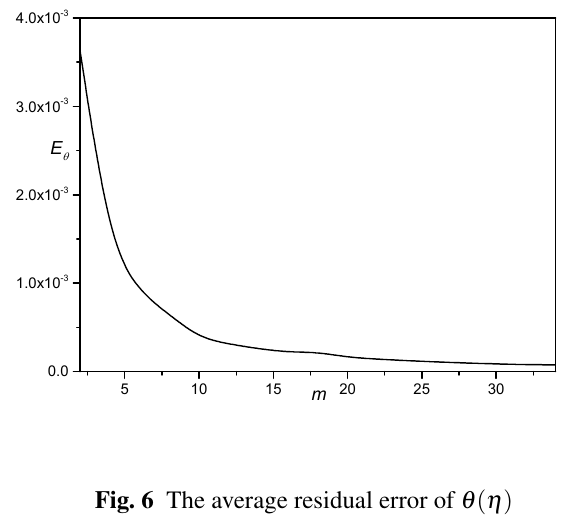
Fig. 6 The average residual error of θ ( η )